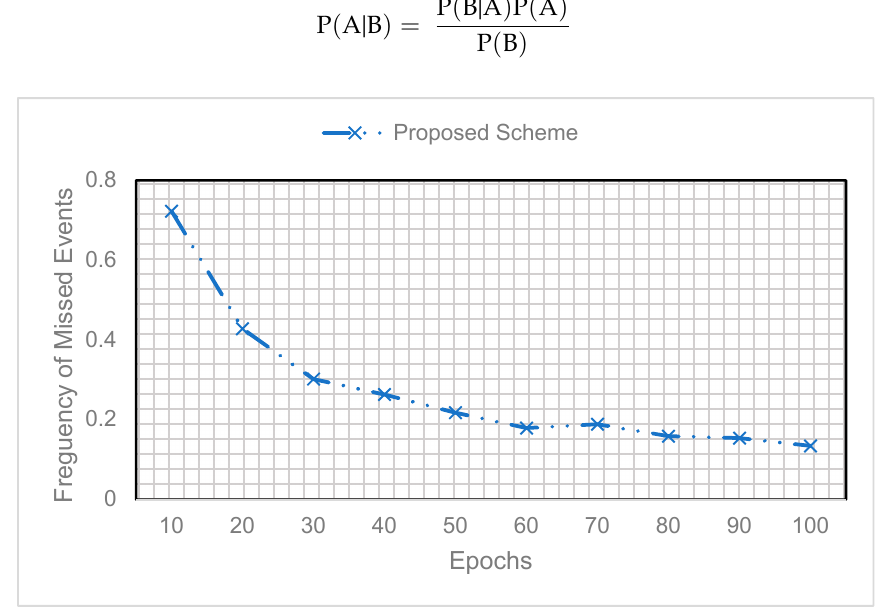
Figure 8. Frequency of the missed events.